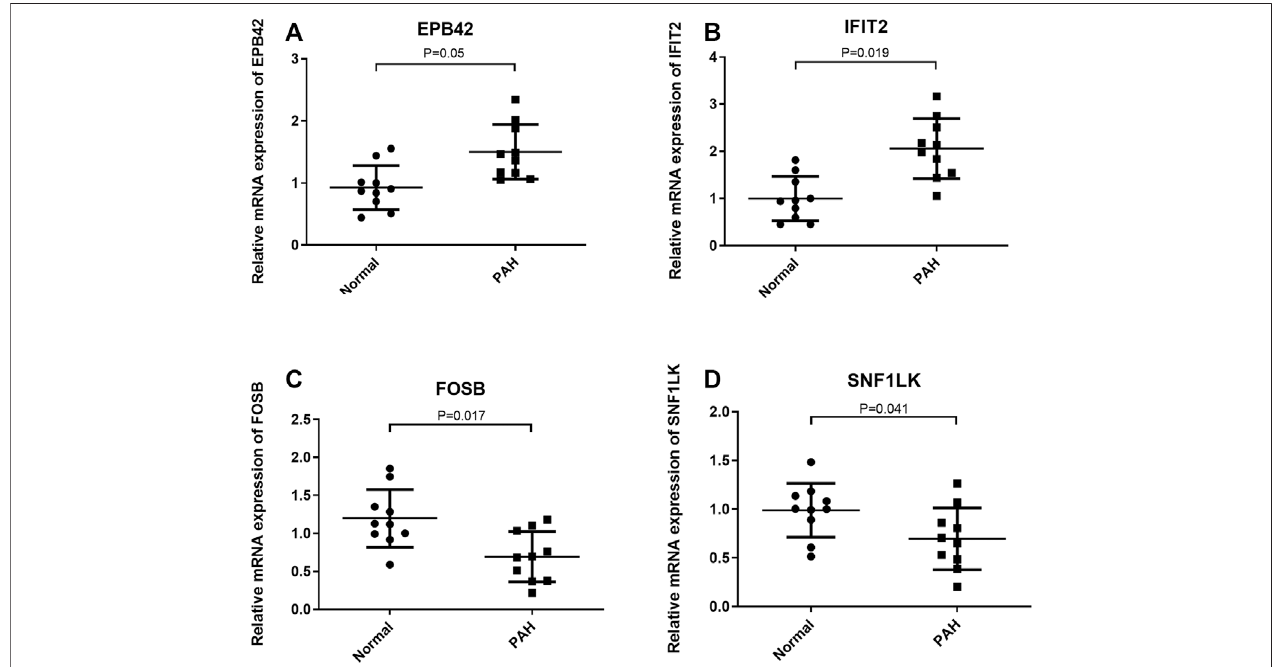
FIGURE 5 | Validation of the expression of optimal feature genes in clinical samples. (A,B) Relative to healthy people, EPB42 and IFIT2 are signi fi cantly highly expressed in the peripheral blood mononuclear cells of PAH patients. (C,D) Relative to healthy people, FOSB and SNF1LK are signi fi cantly lowly expressed in the peripheral blood mononuclear cells of PAH patients. * p <